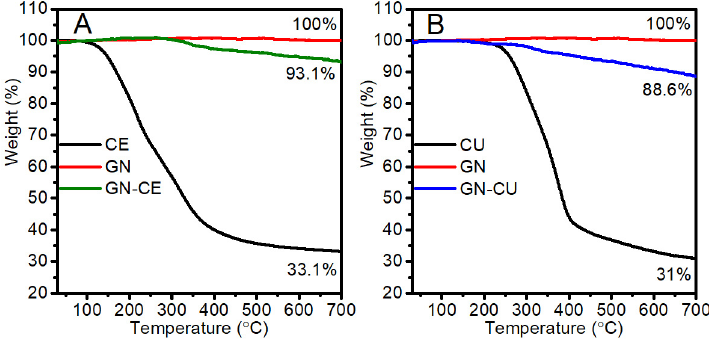
Figure 4. TGA of curcumin, GN, GN–CU ( A ), and Curcuma longa L extract and GN, GN–CE ( B